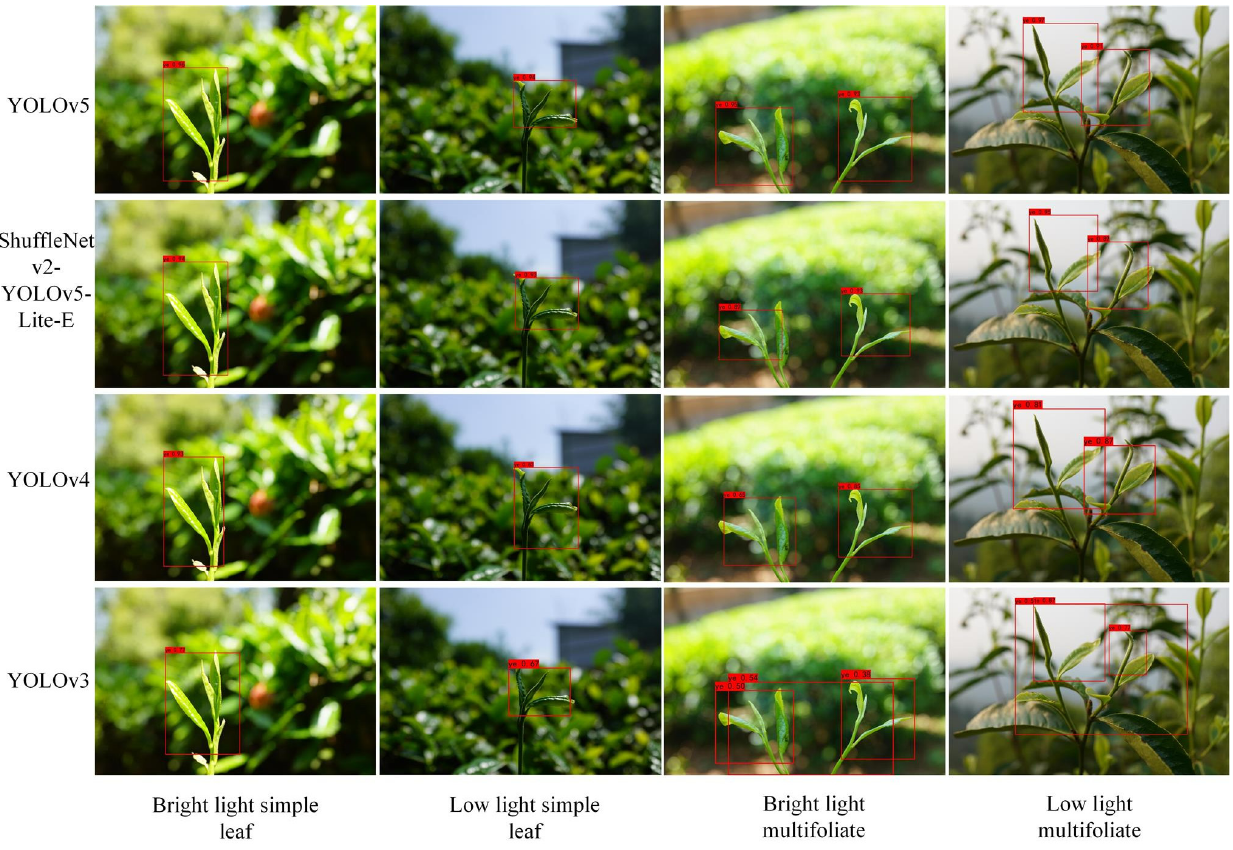
Figure 7. PC comparison results.